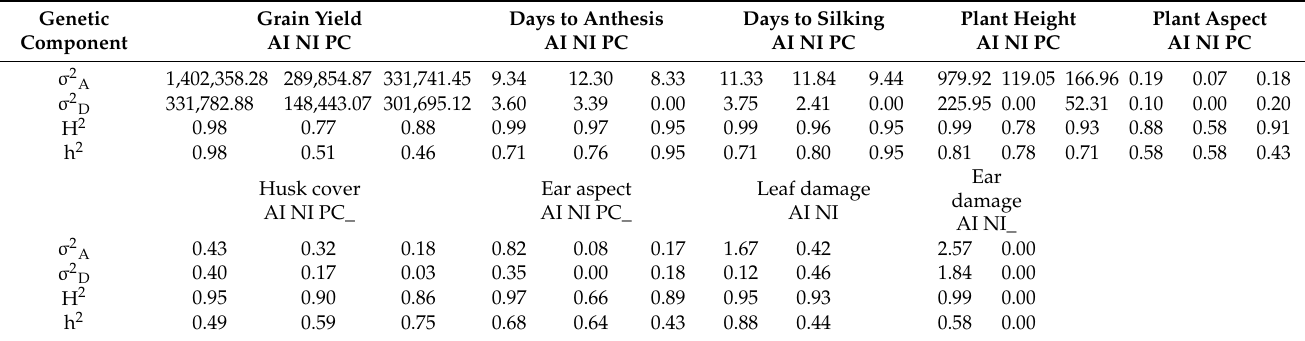
Table 3. Genetic components and heritability estimates for agronomic and fall armyworm (FAW)- resistant traits of maize testcross hybrids evaluated under FAW infestations and pesticide-protected conditions in Nigeria.